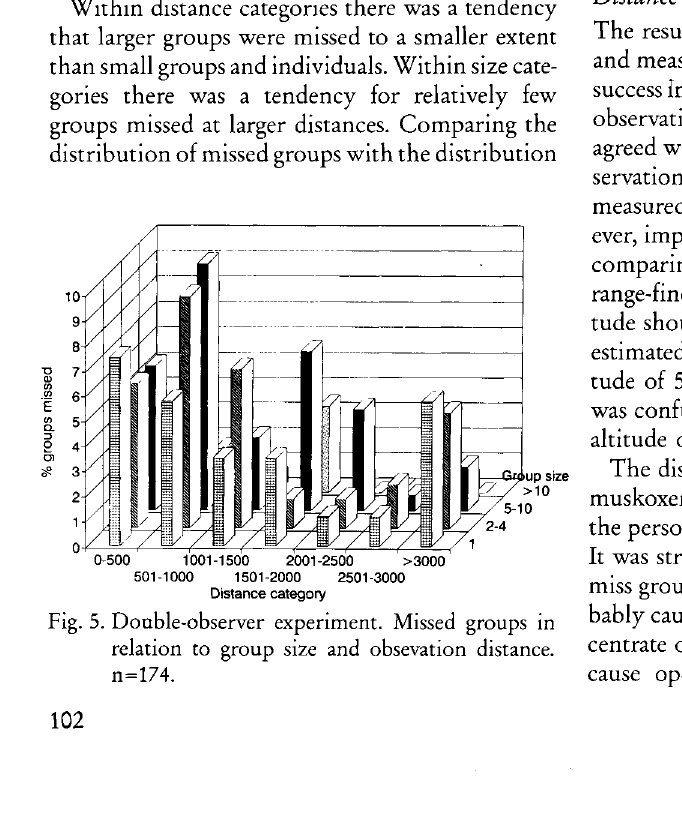
Fig. 6. Observed groups in relation to group size and ob servation distance.